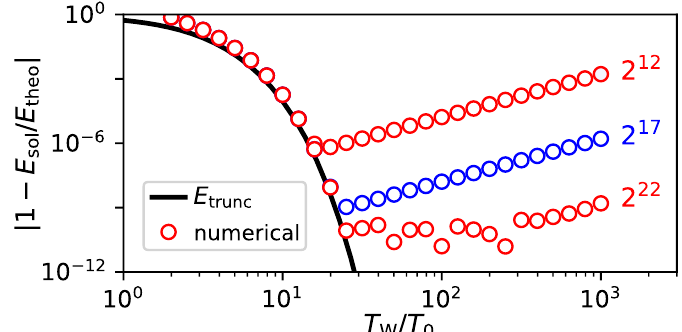
Figure 9. Direct scattering analysis of an N = 1 soliton with different time window widths T W / T 0 . The difference between the soliton energy found by direct scattering transform (DST) and the analytical value is shown. Labels on the right indicate the number of sample points used. Solid curve: expected truncation error, Equation (28) of the input